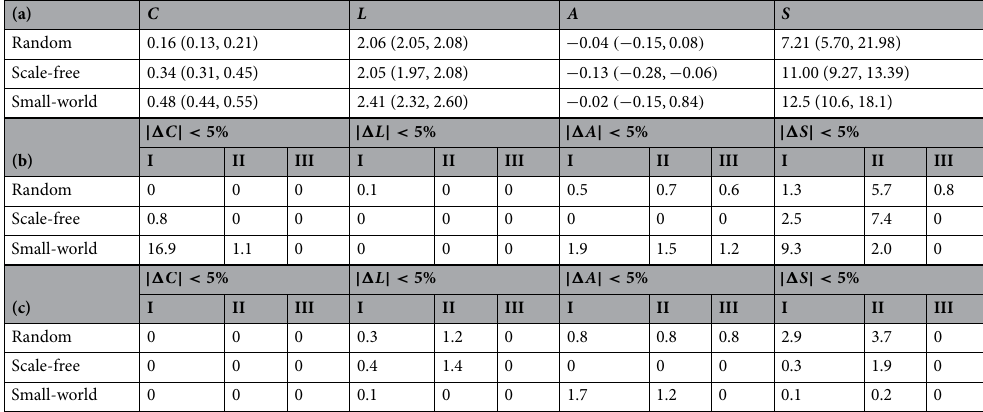
Table 1. Global network aspects of structural networks (a) and relative frequency of vanishing relative f G f differences of global network aspects for G µ (c). (a) Median and range (in brackets) of σ (b) and for measures of global network aspects (global clustering coefficient C , average shortest path length L , assortativity A , and synchronizability S ) from 20 realizations of paradigmatic coupling topologies (small-world, random, and scale-free). (b) and (c) Percentage of pairs of a structural and a functional network for which absolute values of relative difference vanish (i.e., | � M | < 5% ; M denotes a placeholder for measures of global network aspects). The pairs are broken down according to the regimes of low (I), of intermediate (II), and of high coupling strengths